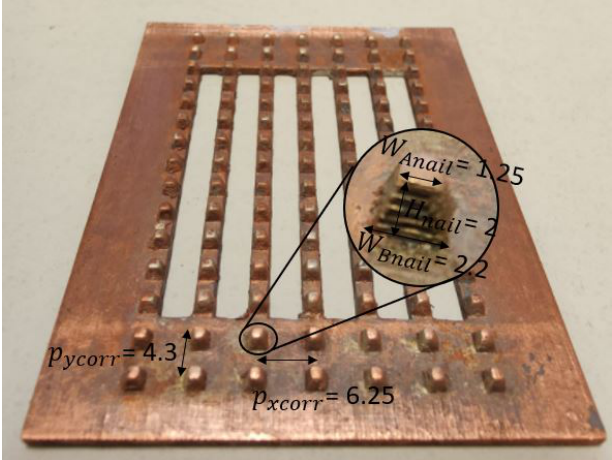
Figure 6. L 4 layer showing the corrugations used for blind scanning reduction of a phased